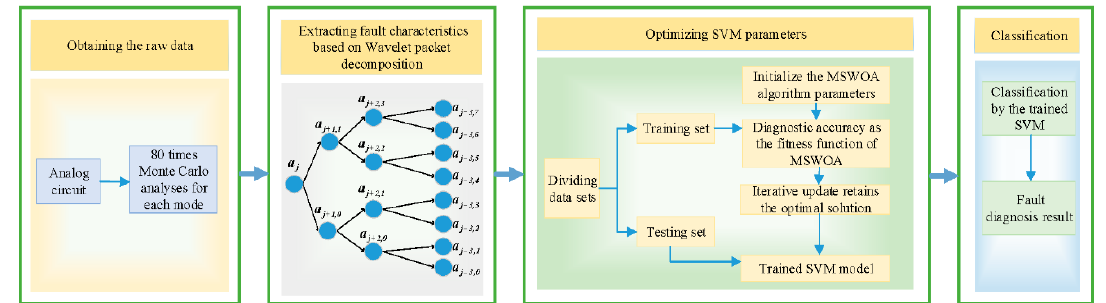
Figure 14. The overall process of analog circuits fault diagnosis.